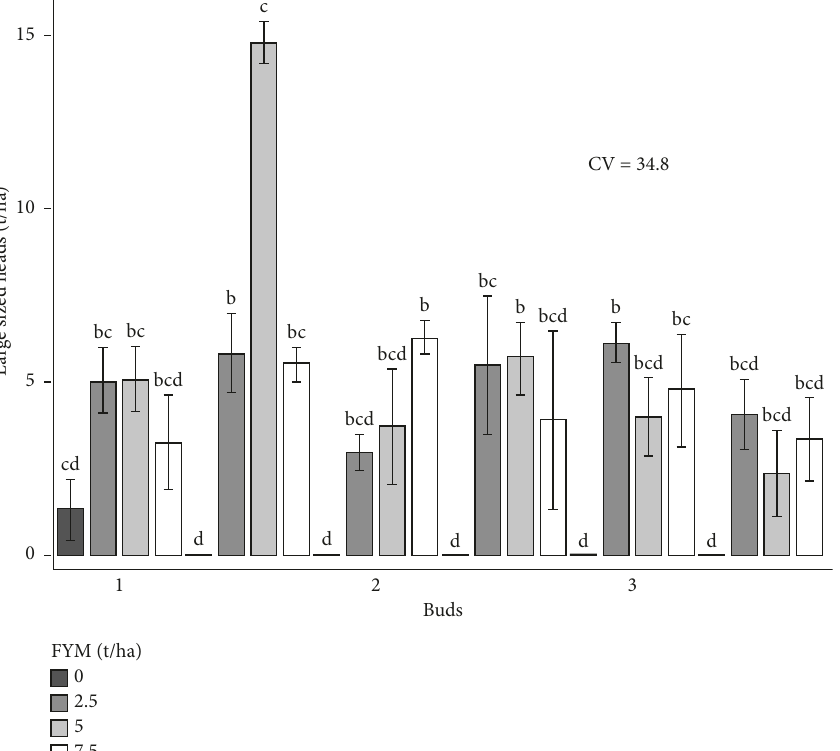
Figure 8: Large-sized heads as influenced by the interaction effect of bud numbers and farmyard manure fertilizer